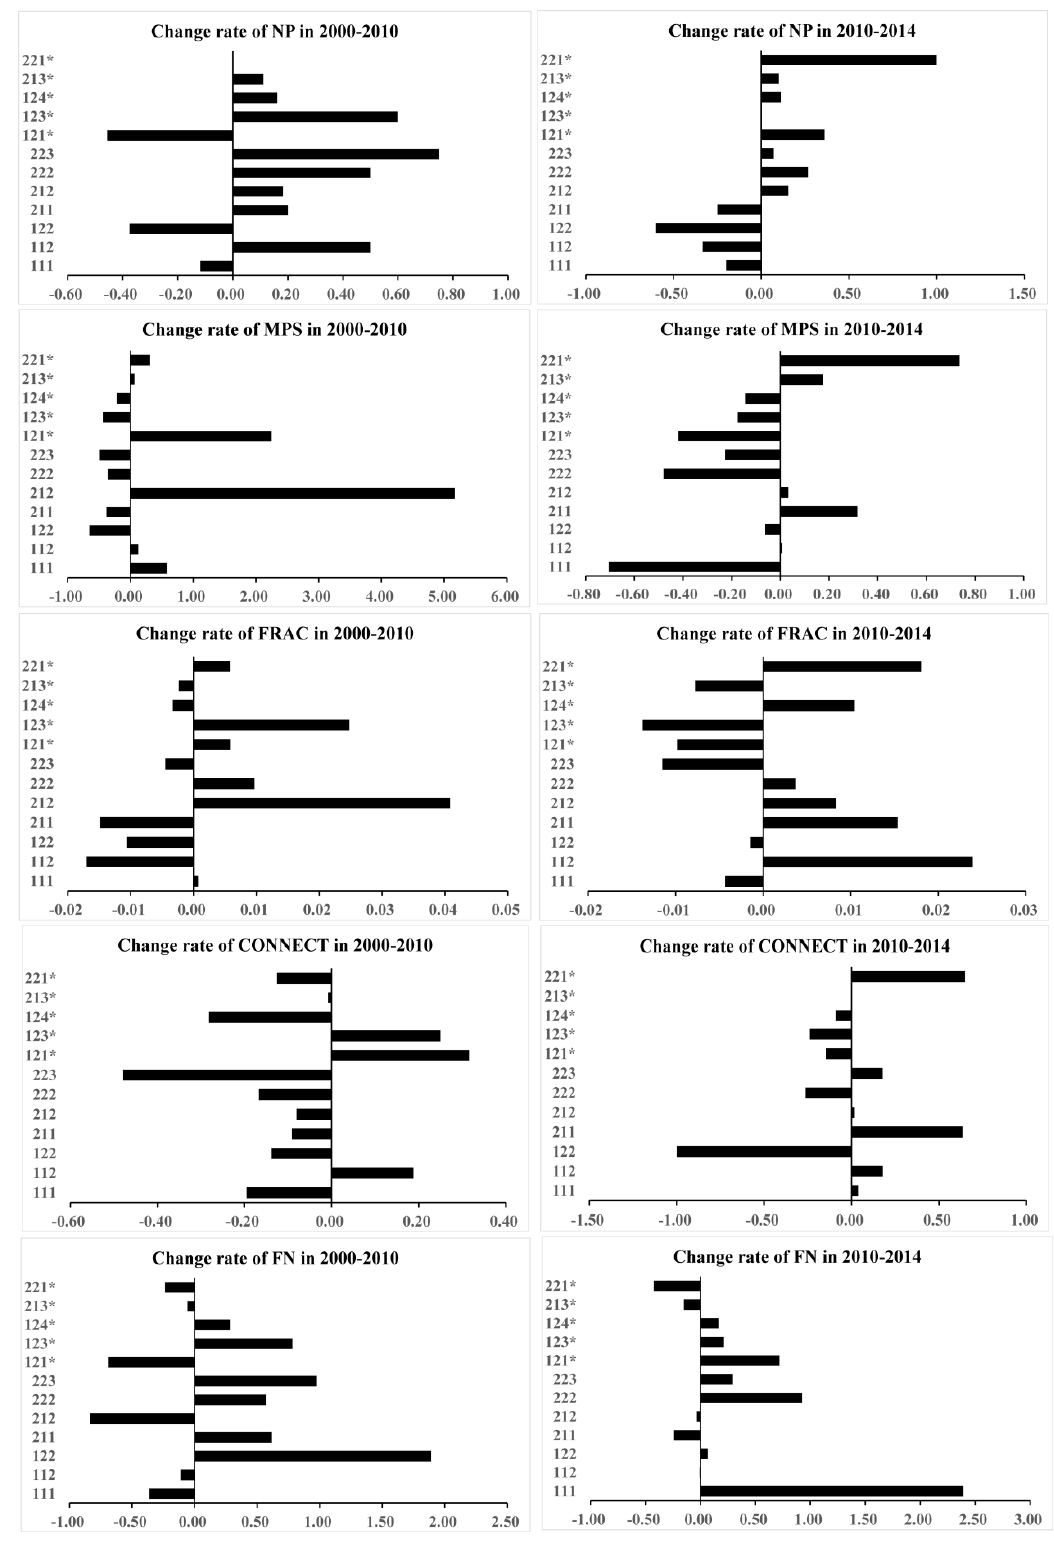
Figure 6. Change rate of shrubs landscape indices for each community in 2000–2010 and 2010–2014. * indicates communities that implemented RFFP. Refer to Table 3 for the abbreviations for landscape metrics. Table 7. Comparison of shrubland landscape indices between RFFP and non-RFFP communities.